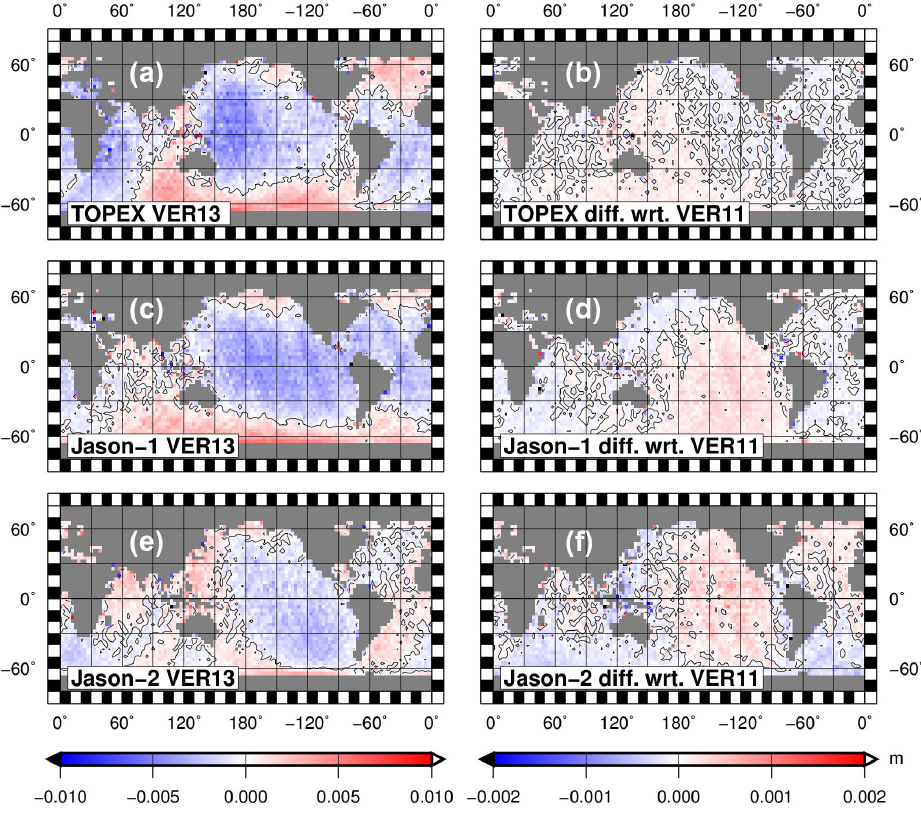
Figure 5. Geographically correlated mean SSH errors for three missions based on ITRF2014 orbits (a, c, e) and VER11-VER13 differences (b, d, f) for TOPEX (a, b) , Jason-1 (c, d) , and Jason-2 (e, f) ; wrt.: with respect to, diff.: difference. Table 7. Rms per cycle, rms, and trend of the global mean over the ocean and maximum regional (absolute) trend values from VER11 minus VER13 radial orbit differences for the combined TOPEX, Jason-1, and Jason-2 series and for subseries. The percentage of the ITRF-related changes relative to the total signal measured by altimetry is given in brackets for